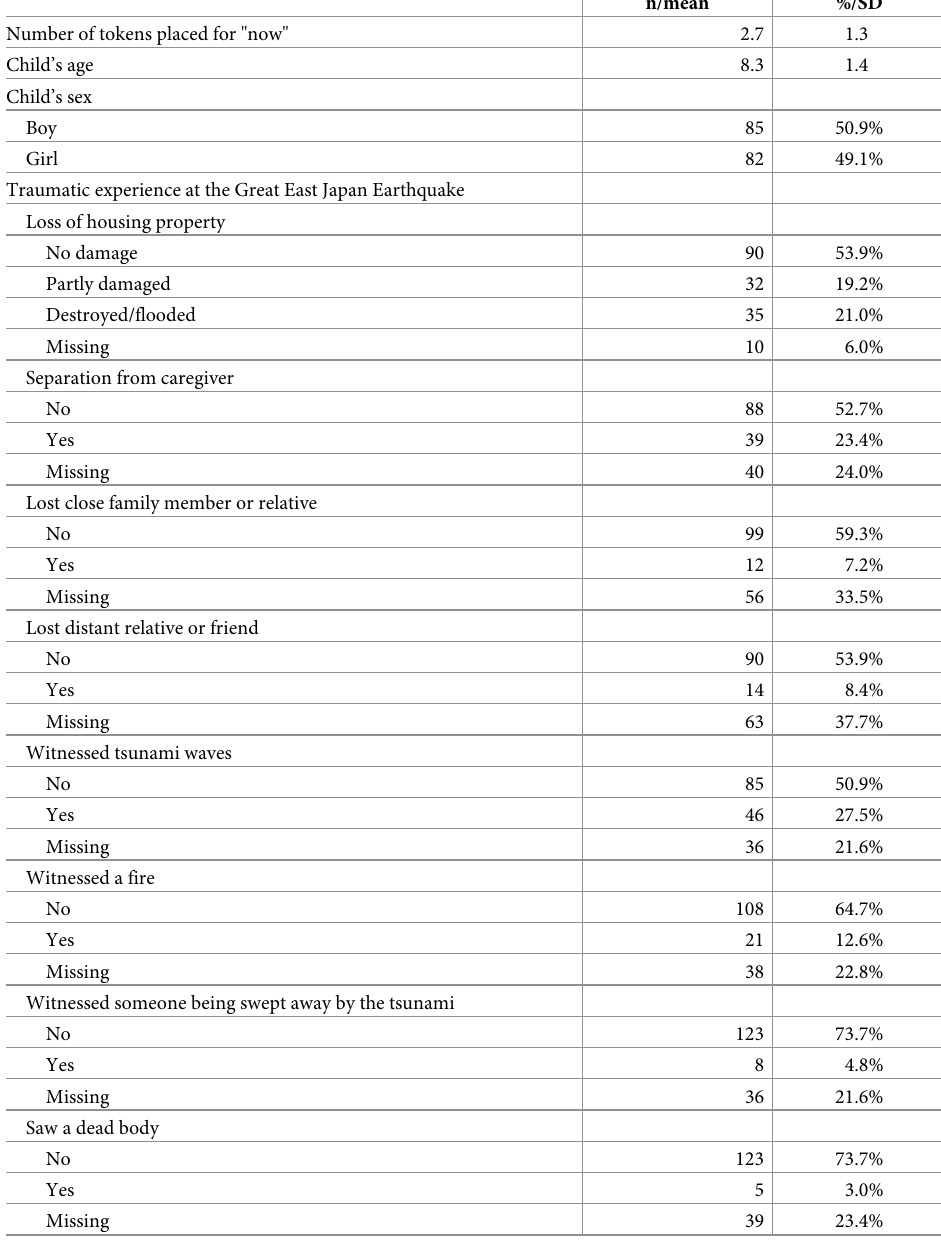
Table 1. Demographic characteristics of children (N =